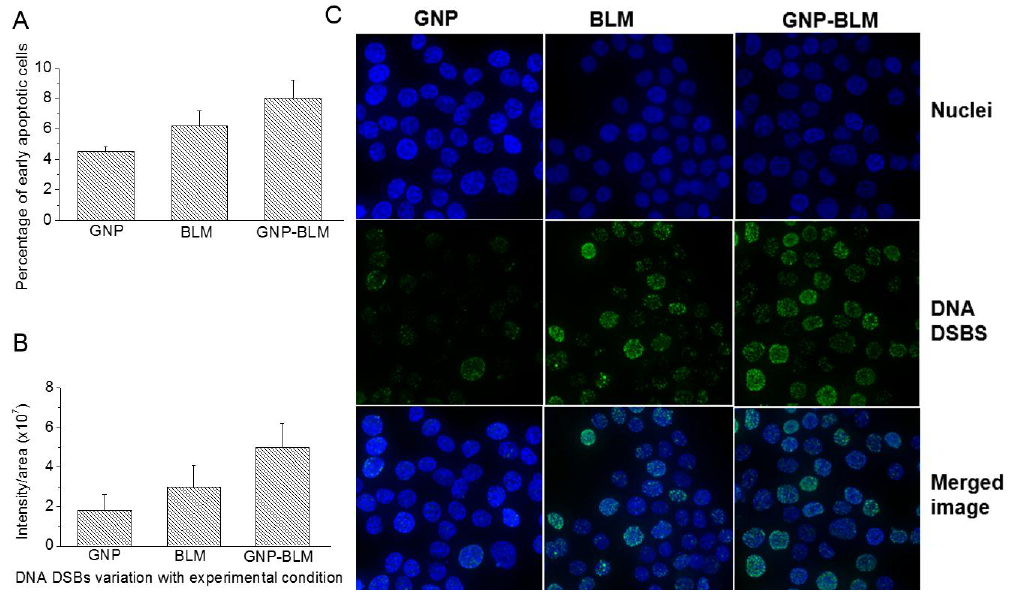
Figure 5. Measuring the efficacy of the drug quantitatively and qualitatively using a cell apoptotic assay and a DNA DSBs assay. ( A ) The average percentages of early apoptotic cells for the control, BLM-treated, and the GNP-BLM treated were 4.5%, 6.3%, and 7.8%, respectively; ( B ) Quantified DNA DSBs for cells treated with as-made GNPs, BLM alone, and the GNP-BLM complex; ( C ) Qualitative optical imaging data corresponding to DNA DSBs for cells treated with as-made GNPs (first column), BLM alone (second column), and the GNP-BLM complex (third column). The first row represents cells stained with DAPI (4',6-diamidino-2-phenylindole) for nuclei staining, the second row represents reflects DNA DSBs (p53-binding protein 1 (53BP1) protein staining with optically tagged antibodies), and the third row represents an overlay of channels corresponding to DNA DSBs and the nucleus.